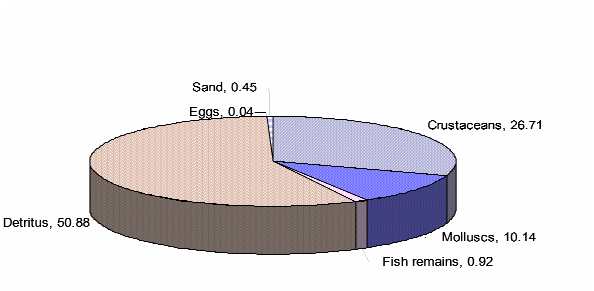
Fig. 1. Diet composition (Index of preponderance) of males of S. melantho